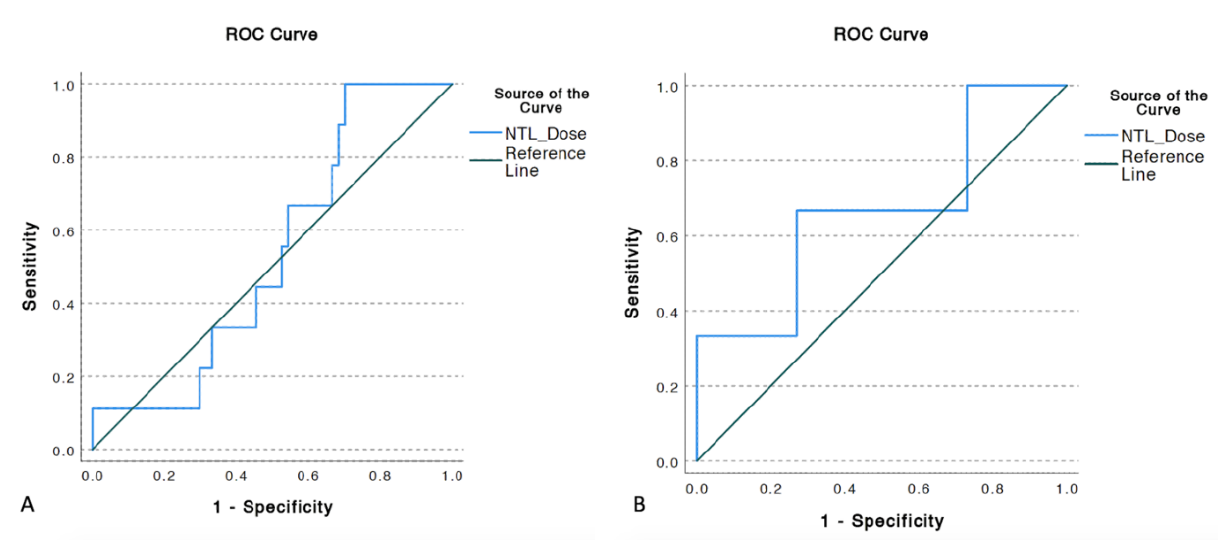
Figure 6. ROC curve for evaluation of relation of mean NTL dose and development of ( A ) CTCAE grade ≥ 3 liver toxicity (AUC: 0.532, p = 0.712) and ( B ) REILD (AUC: 0.667, p = 0.349) demonstrated mean NTL dose to not be a statistically significant predictor for either outcome.